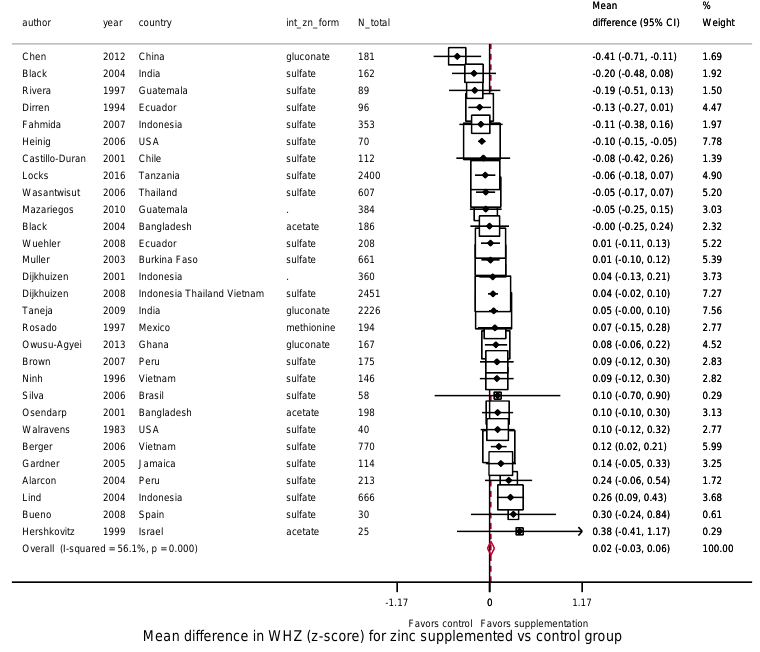
Figure 5. Effect of zinc supplementation among children aged < 5 y old on WHZ in randomized F igure 5: Effect of zinc supplementation among children aged<5 y old on WHZ in randomized controlled controlled trials.